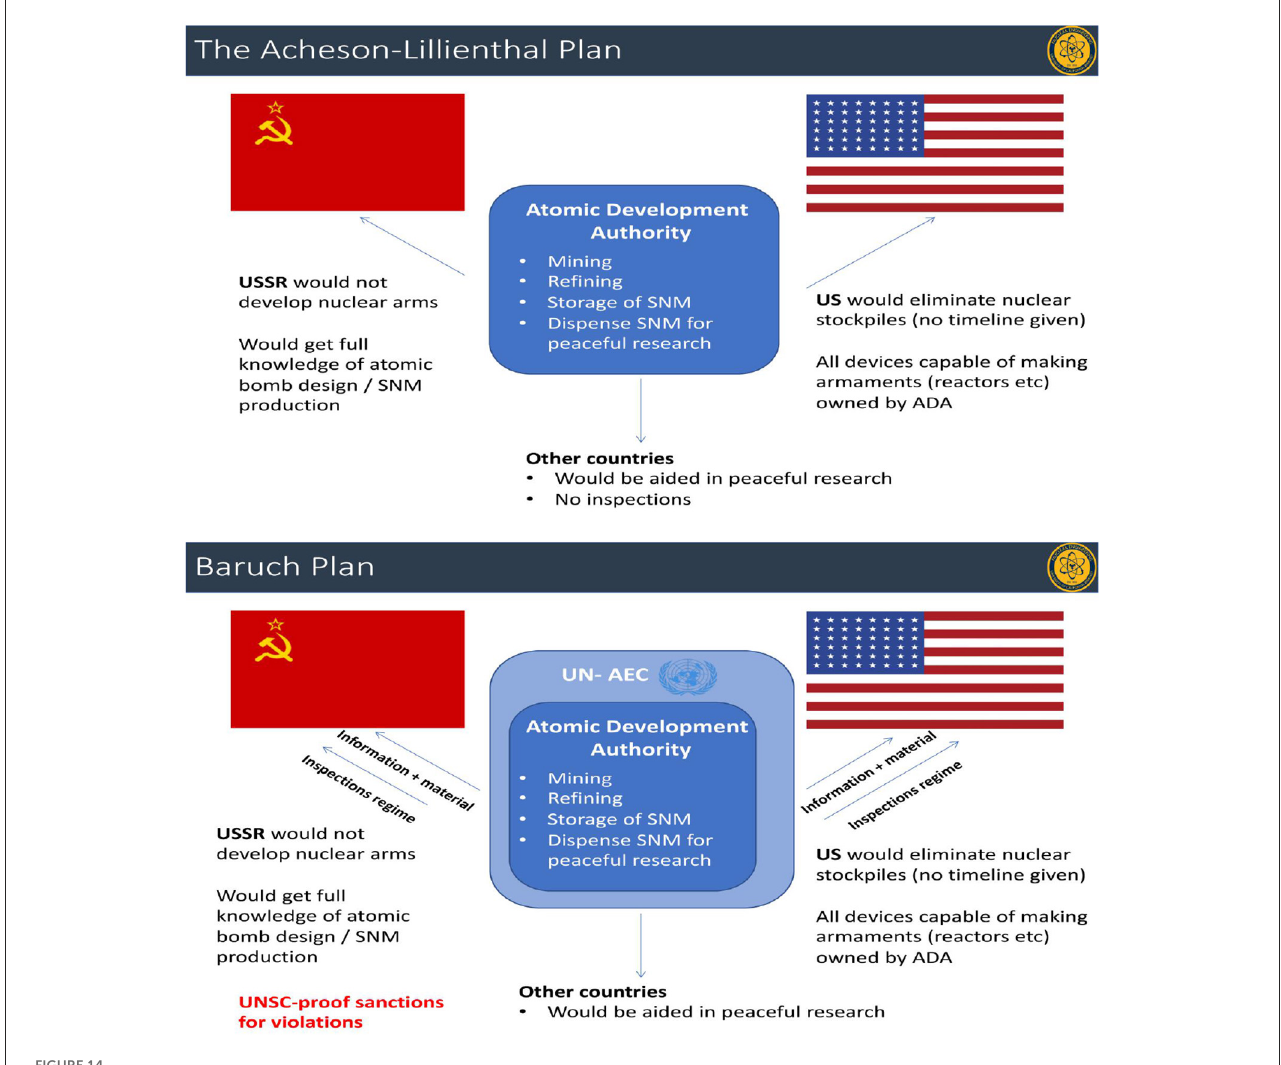
FIGURE14 Slides outlining the Acheson-Lillienthal (top) and Baruch (bottom) plans.